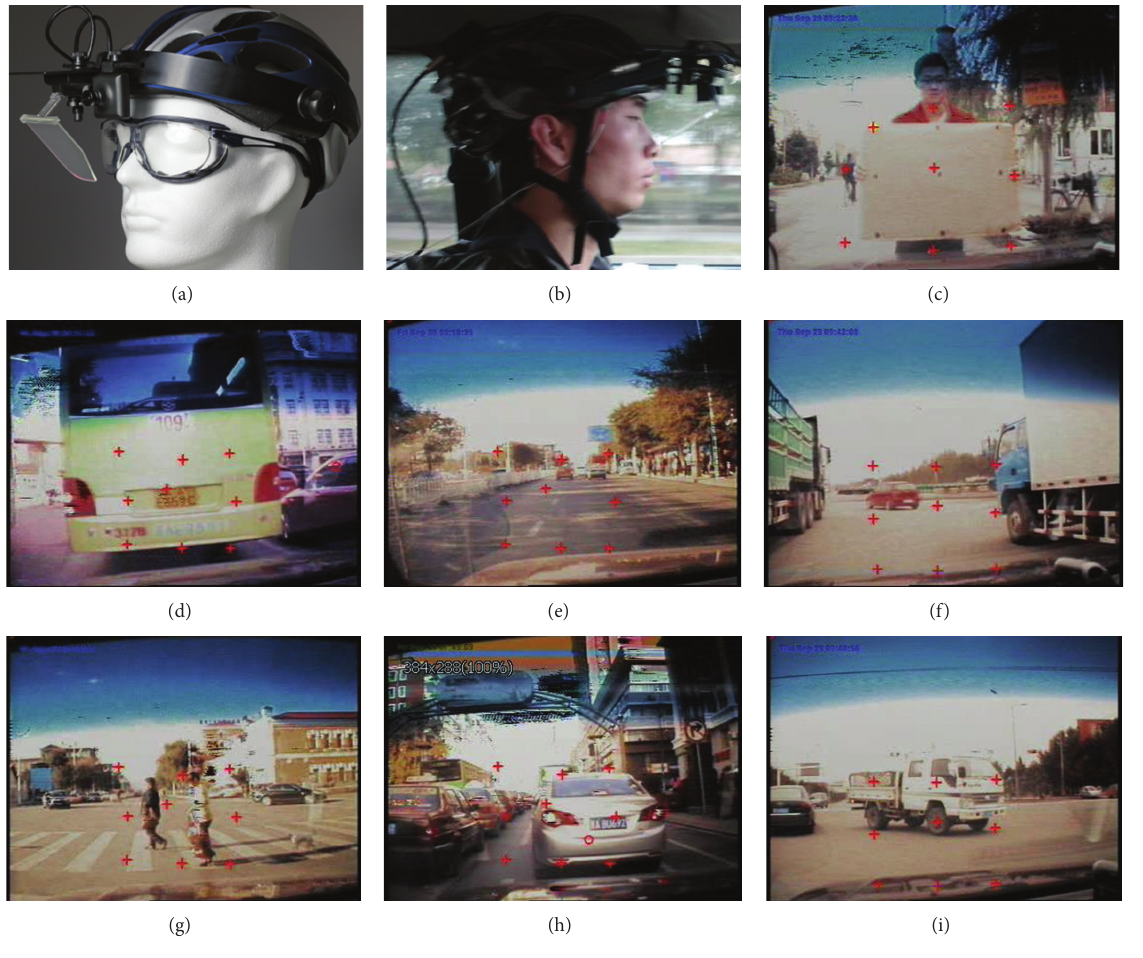
Figure 3: Test scenarios of driver’s visual characteristics.